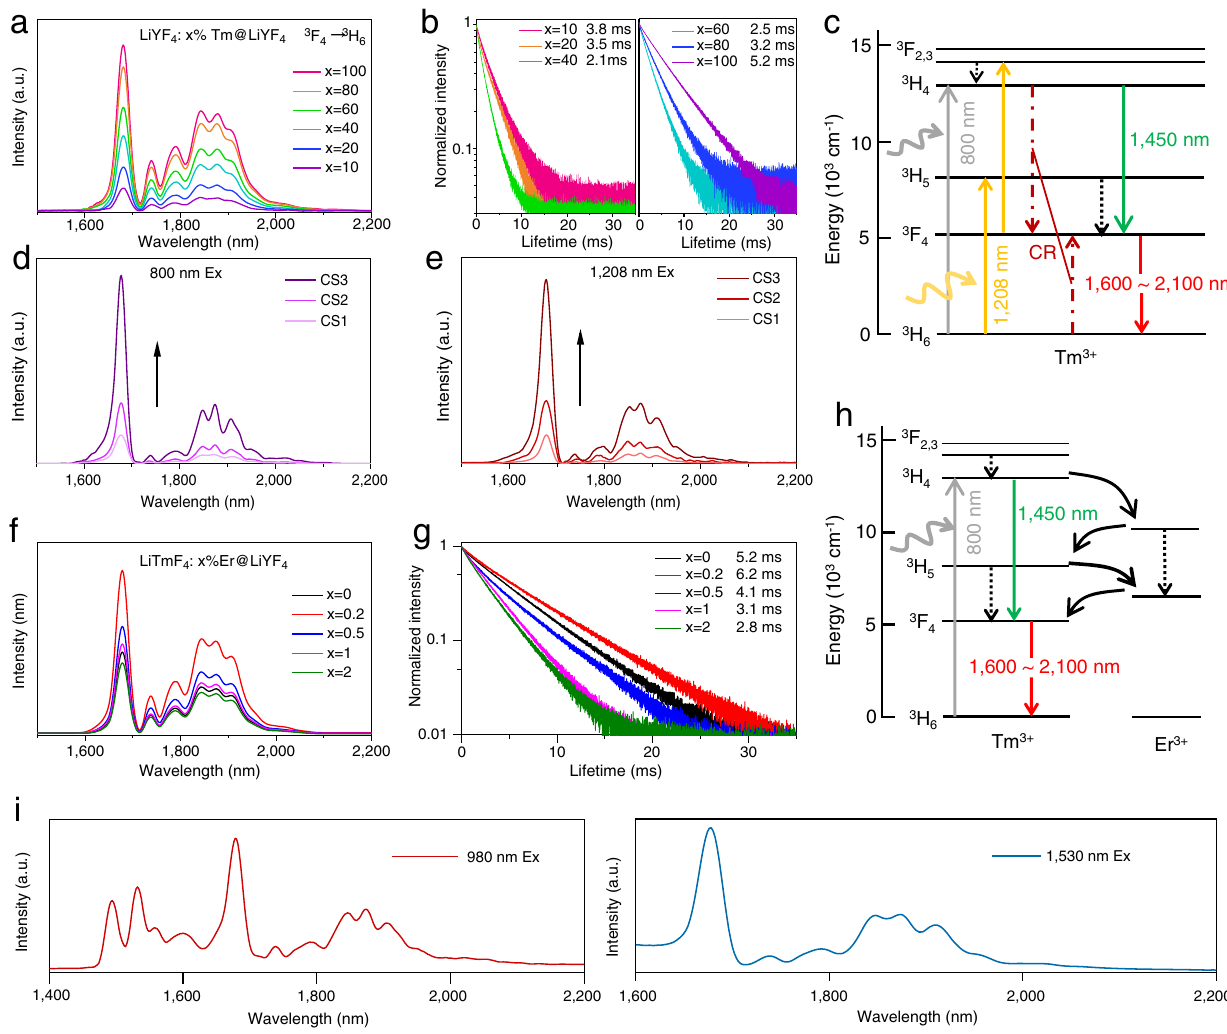
Fig.2|PhotoluminescencecharacterizationoftheTm-NPswithenhancedNIR- IIb/cluminescence.a Emissionspectraofthecore-shellTm-NPswithvariableTm 3+ dopant concentrations in the core showing DSL from 1600 to 2100nm upon excitation at 800nm. b Corresponding decay times. c Proposed downshifting mechanism for Tm 3+ in the NIR-II region. d, e LiTmF 4 @Y NPs with different shell